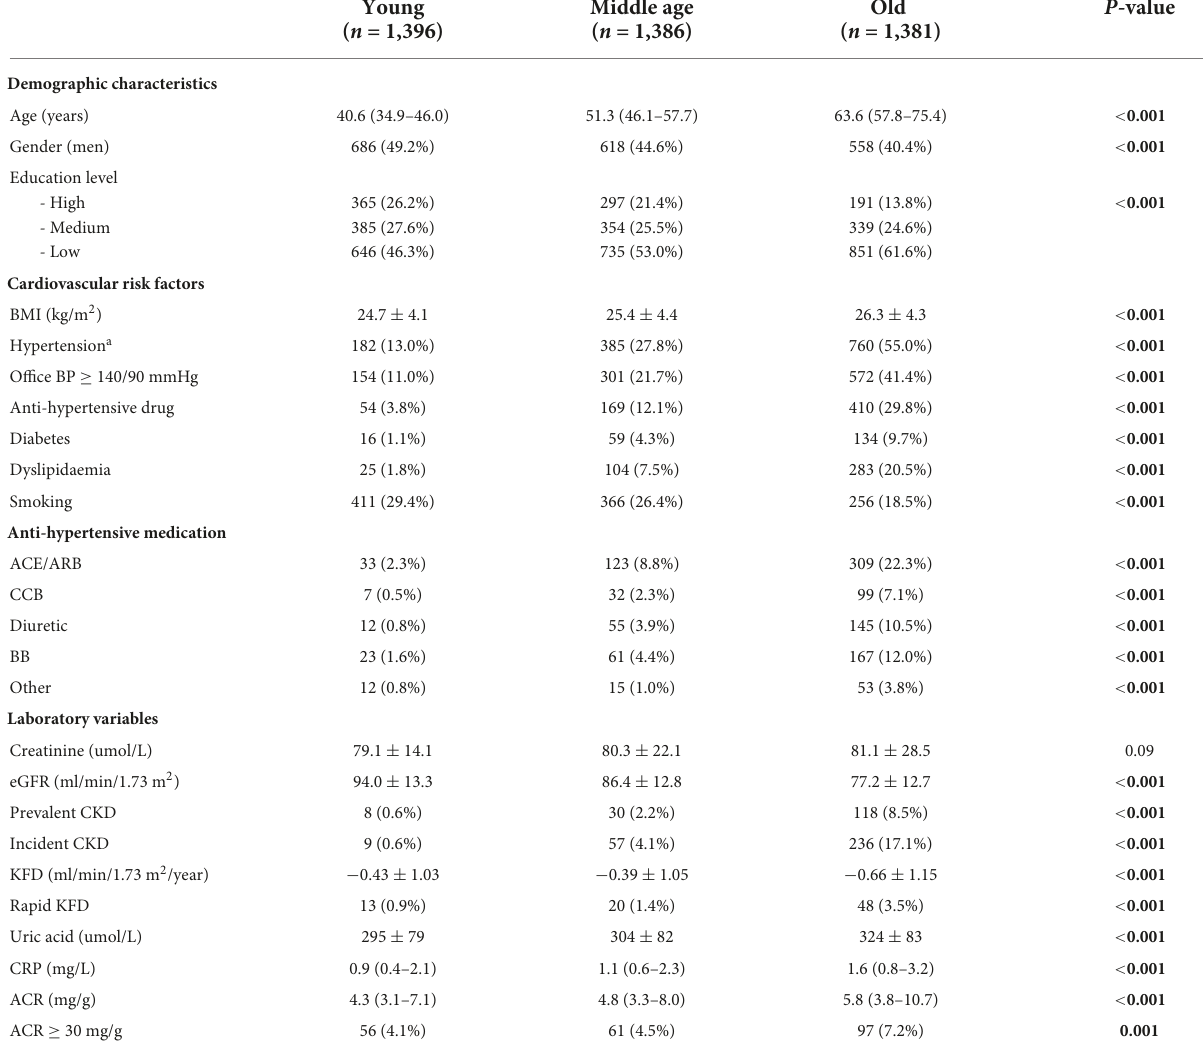
TABLE 1 Baseline characteristics of included participants according to age tertiles ( n = 4,163).